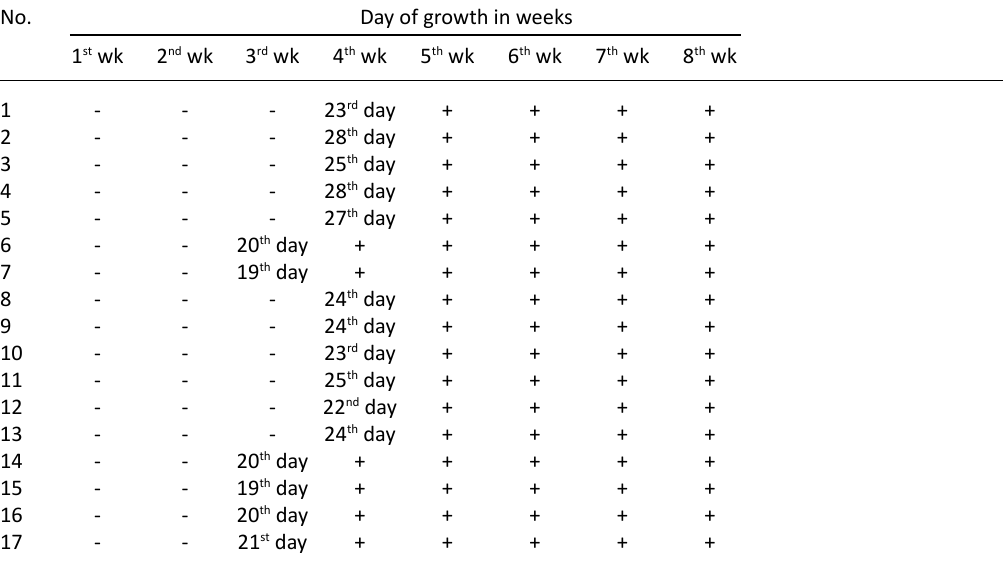
Table 5(a). Time to detection (TTD) of culture positivity samples in MGIT